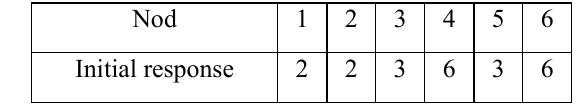
Fig. 4 . Initial response designed for hub covering location